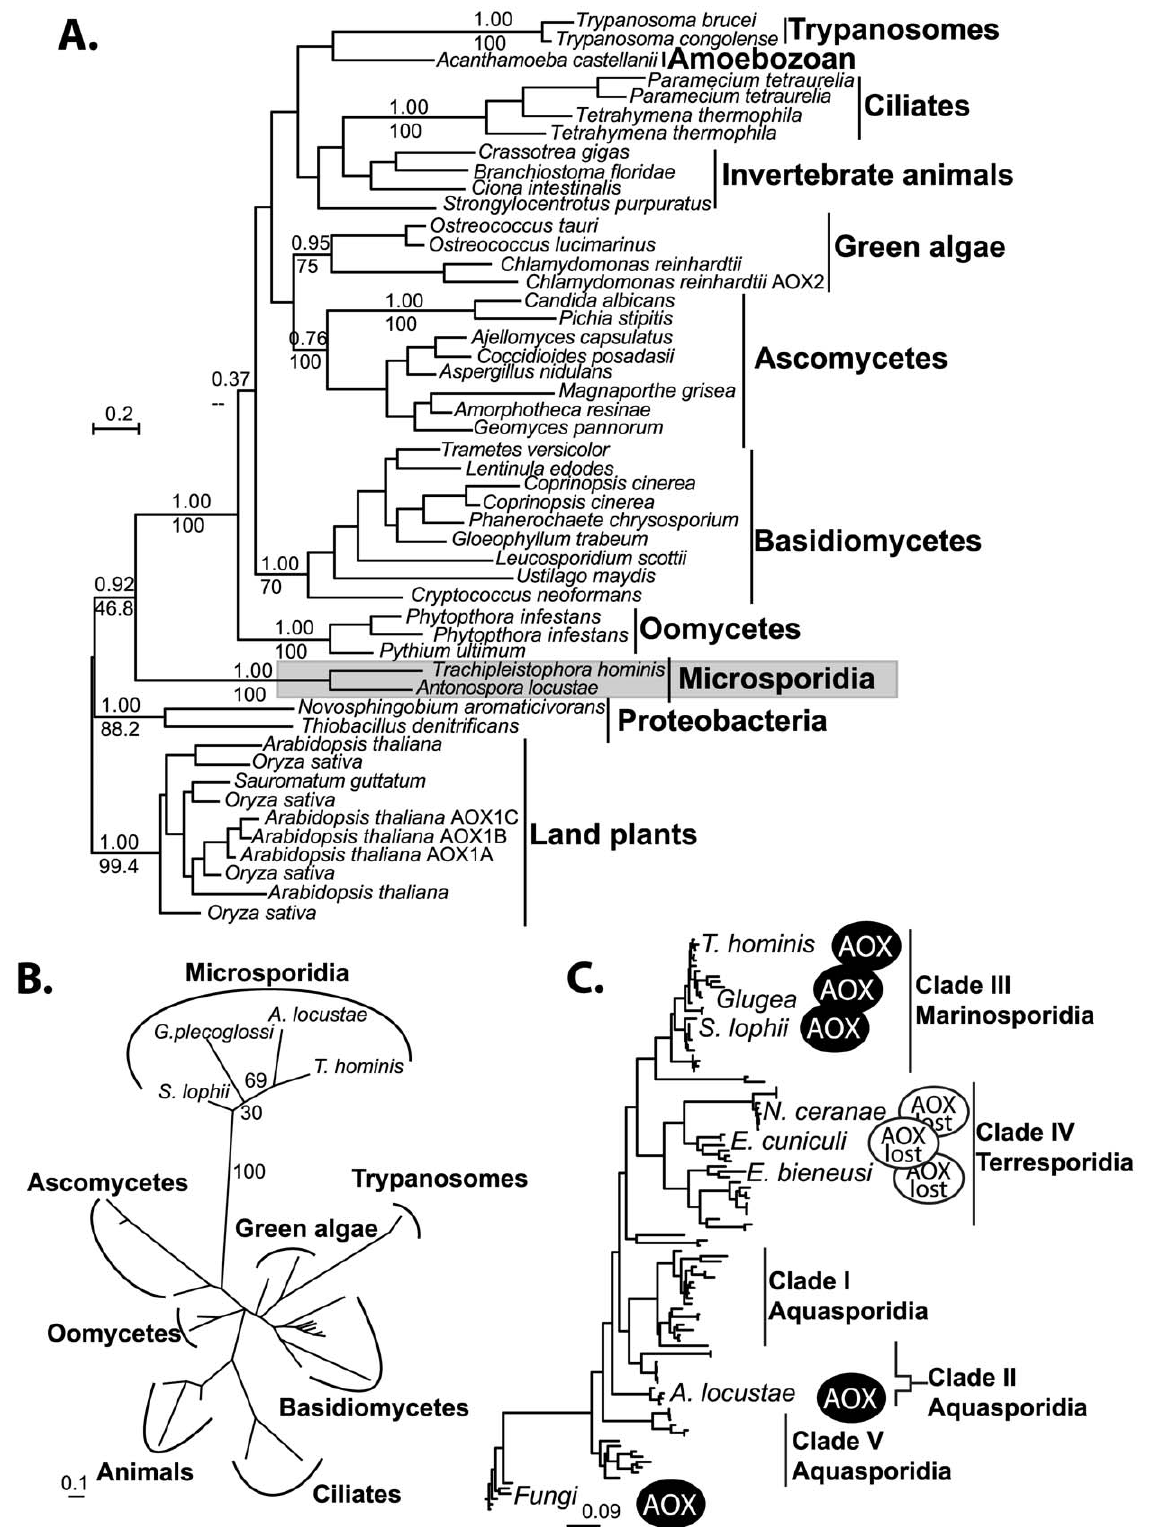
Figure 3. Phylogenetic analyses of microsporidian AOX sequences. A. Global MrBayes AOX phylogeny, posterior probabilities and PhyML bootstraps from an analysis of 500 bootstrapped datasets are shown above and below respectively, key and well supported clades ( . 70% Bootstrap). B. Short alignment PhyML phylogeny including the translated amplified sequences from all four microsporidia. Bootstrap support from 100 datasets is shown next to microporidian nodes. C. Microsporidian distribution of the alternative oxidase gene plotted onto a phylogeny of microsporidian SSU rDNA sequences. Scale bars in all trees indicate substitutions per site.